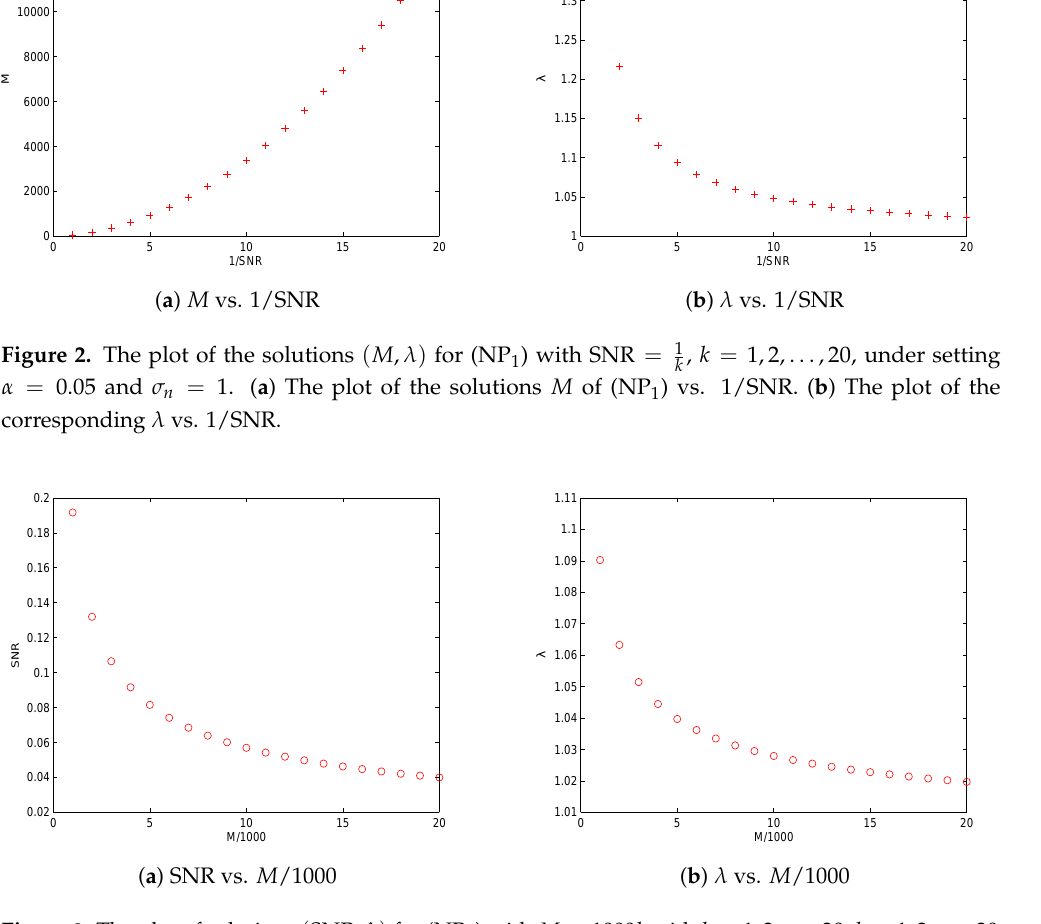
Figure 3. The plot of solutions ( SNR, λ ) for (NP 2 ) with M = 1000 k with k = 1,2, . . . ,20, k = 1,2, . . . ,20, under setting α = 0.05 and σ n = 1. ( a ) The plot of SNR vs. M /1000. ( b ) The plot of corresponding λ vs. M